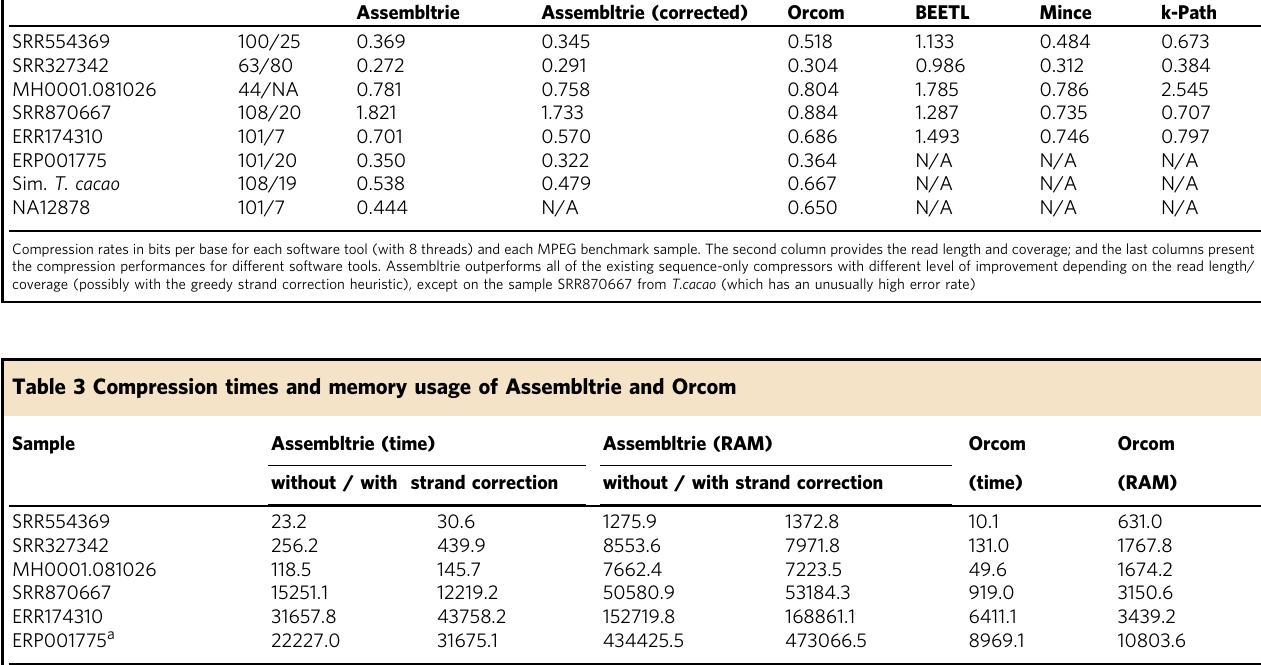
Table 2 Comparative compression ratios achieved by Assembltrie on the MPEG HTS benchmarking data set Sample